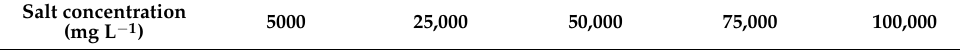
Table 5. Variation of pH at different concentrations of salt in the desalter wastewater.